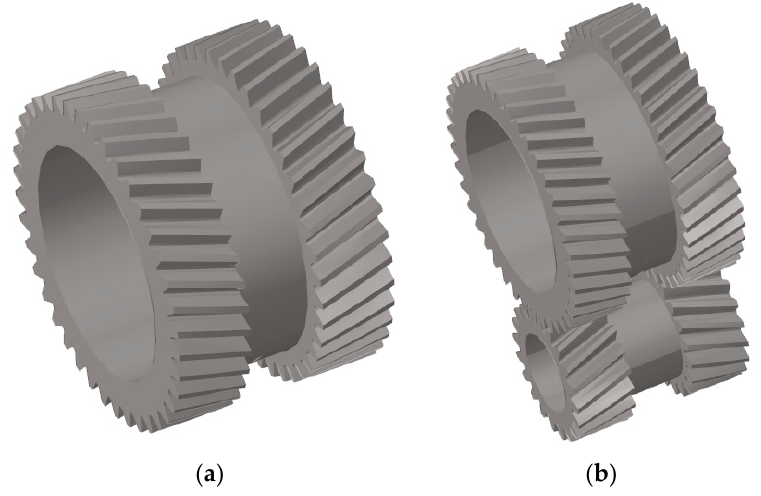
Figure 1. Photographs of herringbone tooth drive. ( a ) Structure of herringbone gear; ( b ) herringbone gear transmission.